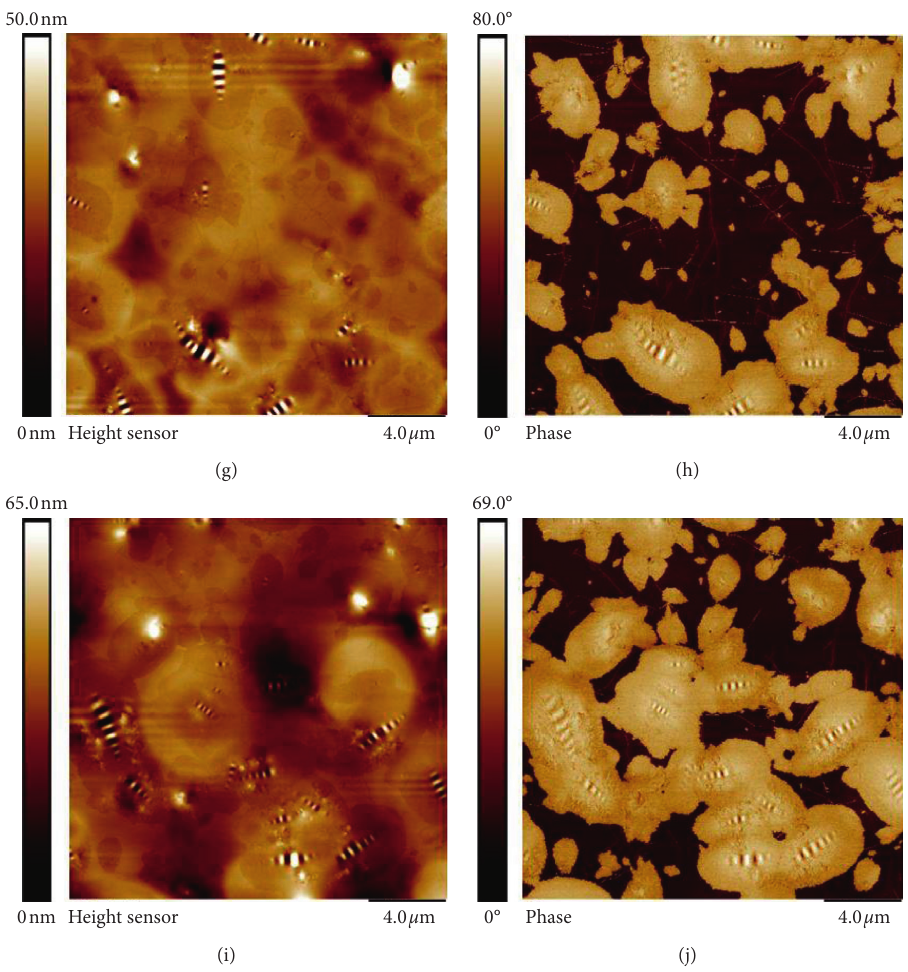
Figure 13: SIS 0% at original state: (a) topographical image; (b) phase image. SIS 5% at original state: (c) topographical image; (d) phase image. SIS 10% at original state: (e) topographical image; (f) phase image. SIS 15% at original state: (g) topographical image; (h) phase image. SIS 20% at original state: (i) topographical image; (j) phase image.